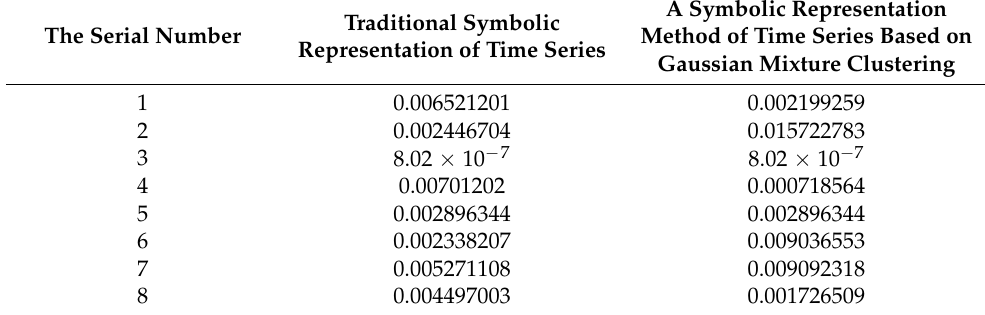
Table 1. Comparison between the symbolic representation method of time series based on Gaussian mixture clustering and the traditional method.